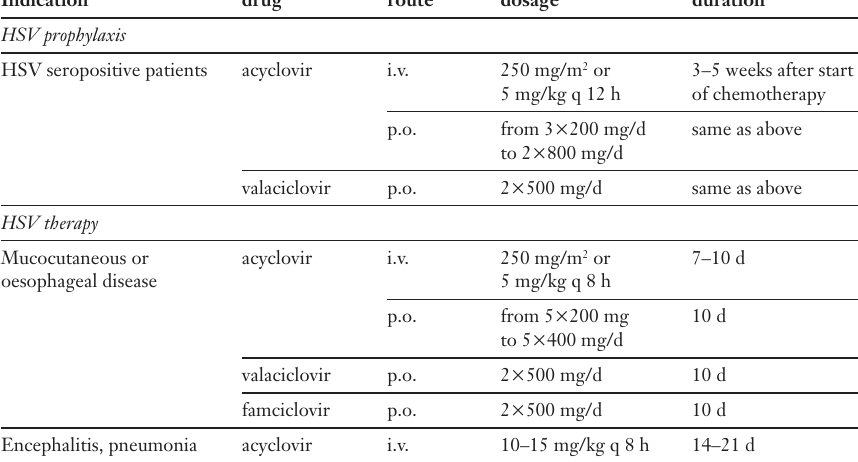
Recommendations for prophylaxis and therapy of HSV dis- ease in immunocom- promised cancer patients.